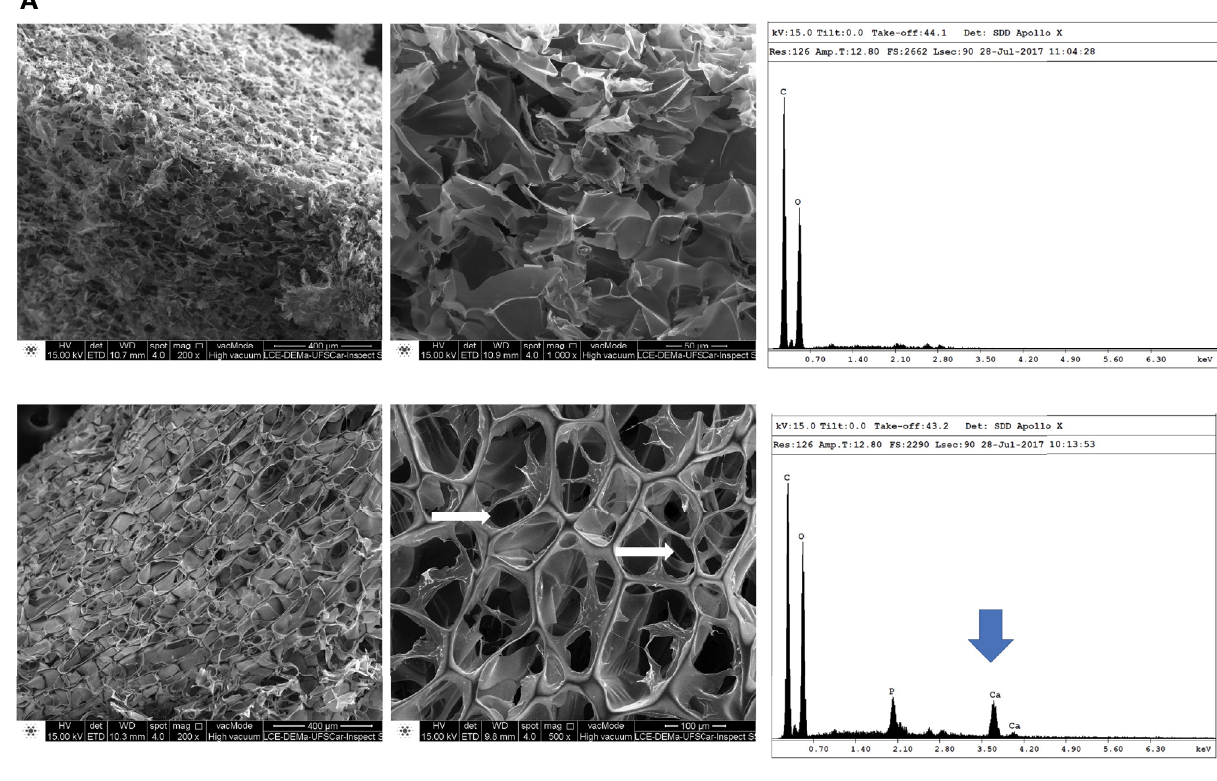
Figure 3. Representative images of scanning electron microscopy (SEM) or energy dispersive spectroscopy (EDS) analysis of the CH and CH-Ca scaffolds. The disorganized, porous architecture of the CH scaffold and the organized, interconnected porous network of the CH-Ca scaffold, with the presence of the Ca component identified using EDS is displayed. White arrows indicate pore-inside-pore on CH-Ca. The blue arrow indicates Ca identification on the EDS graph of